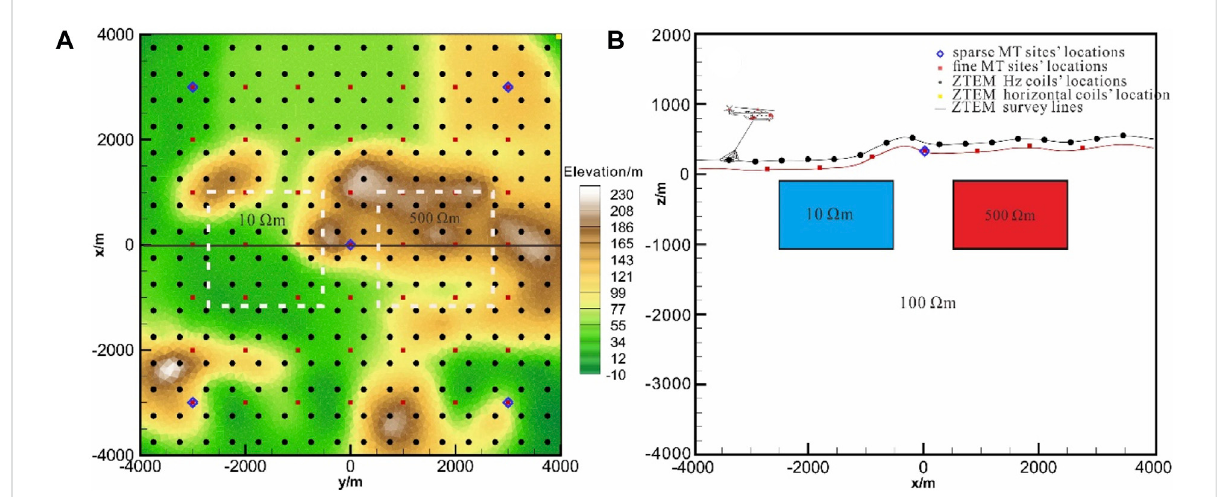
FIGURE 8 Survey grids for the synthetic model. The three grids are coarse MT (red squares), fi ne MT (blue diamonds), and ZTEM (black circles). The blue square is the ZTEM base.